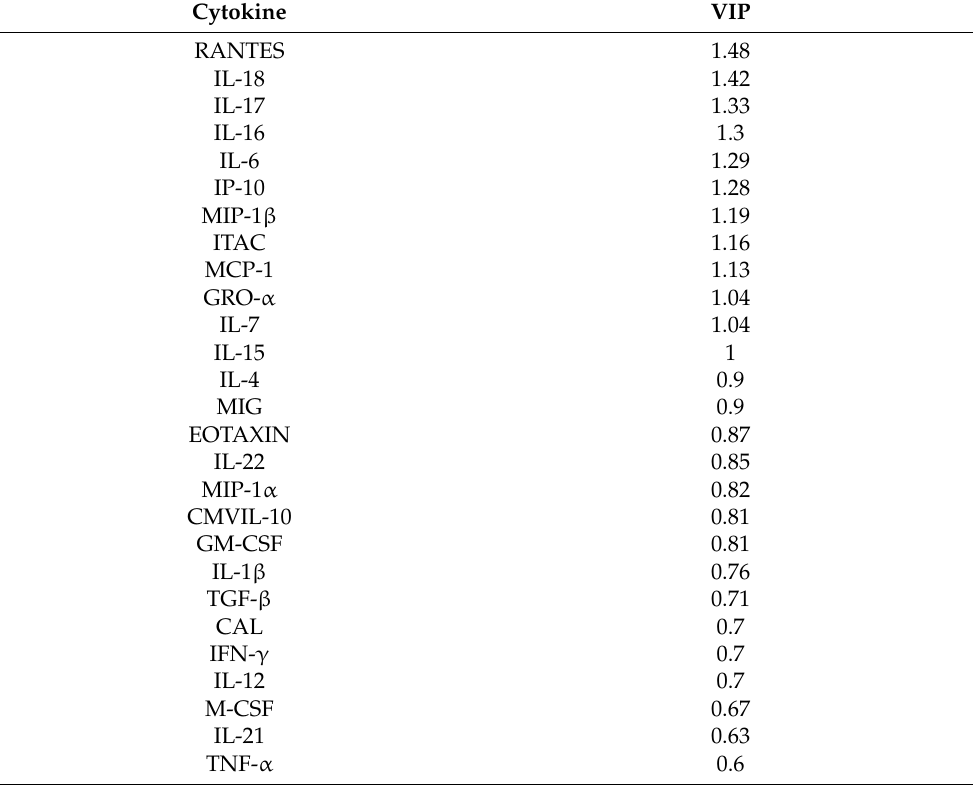
Table 5. VIP scores for each cytokine: CMV shedders versus non-shedders.